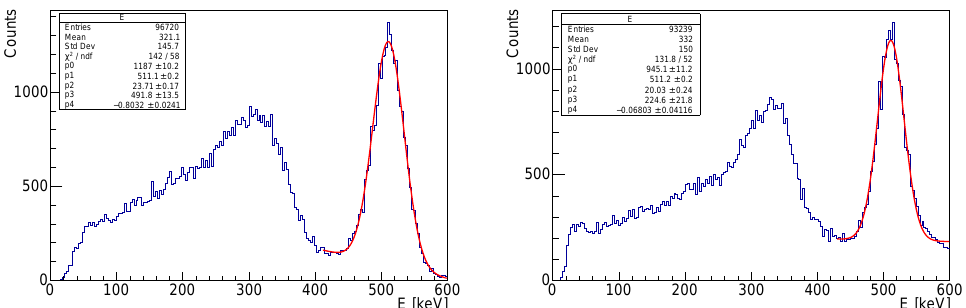
Figure 4. The spectra of 511 keV gammas from 22 Na measured by a crystal from Module I at V OV = 4 V ( left ) and from Module II at V OV = 3 V ( right ). The fit function is the one given in Equation (3). The spectra with the best obtained energy resolutions are shown: ∆ E / E = 10.9% for the Module I and ∆ E / E = 9.2% for the Module II.